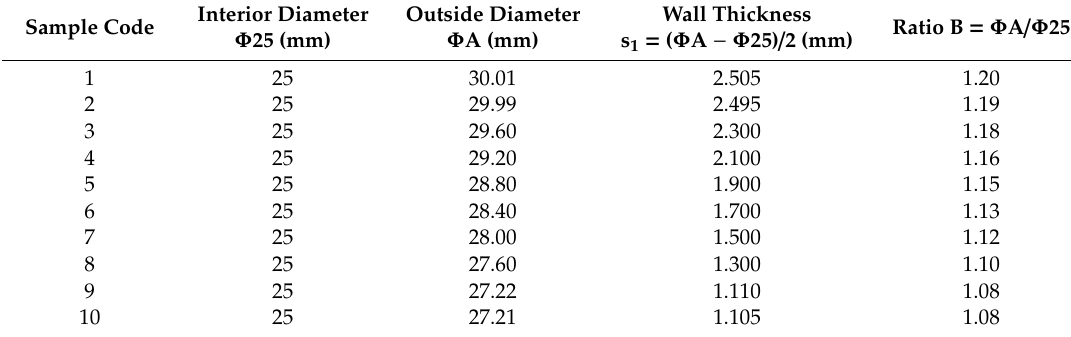
Table 1. Geometrical characteristics of